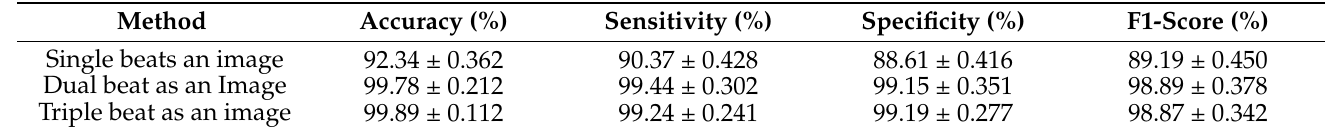
Table 7. ECG beat template matching 10-fold cross-validation performance.